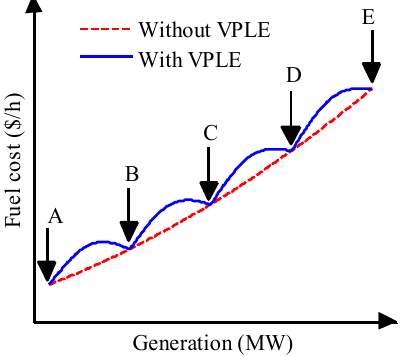
Figure 3. Cost characteristic with and without VPLE.